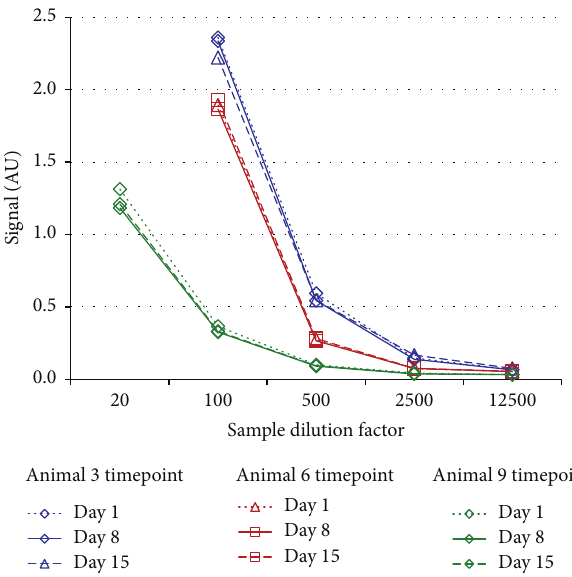
Figure 4: Representative anti-DLL4 F(ab 󸀠 ) 2 bridging ATA assay titer curves from three cynomolgus monkeys sampled weekly, three samples per animal total. The signals were consistent within animal but varied widely between